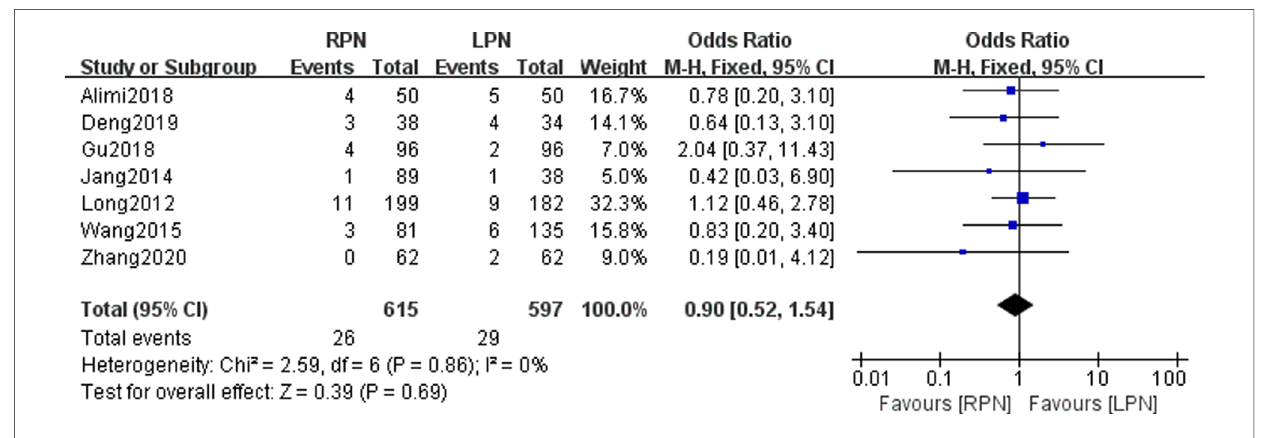
FIGURE 12 Forest plot for major postoperative complications between the RPN and